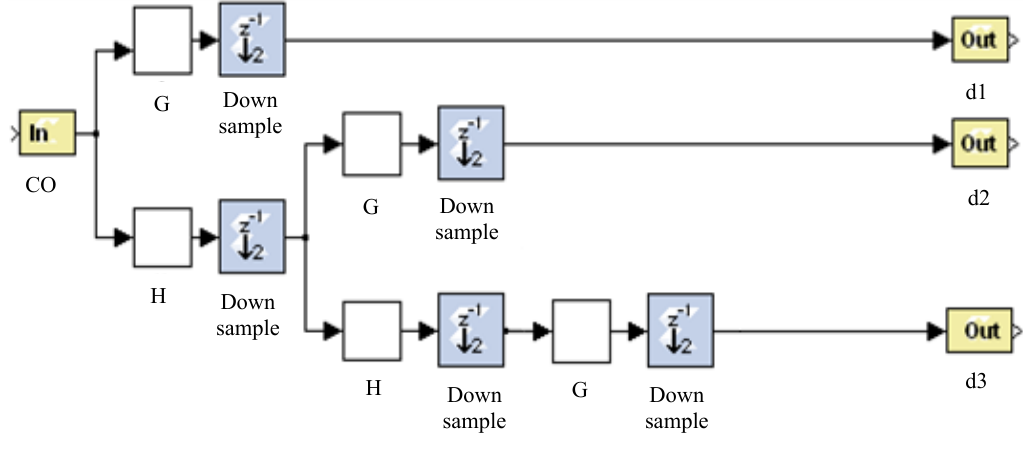
Figure 5. Calculation of wavelet coefficients d